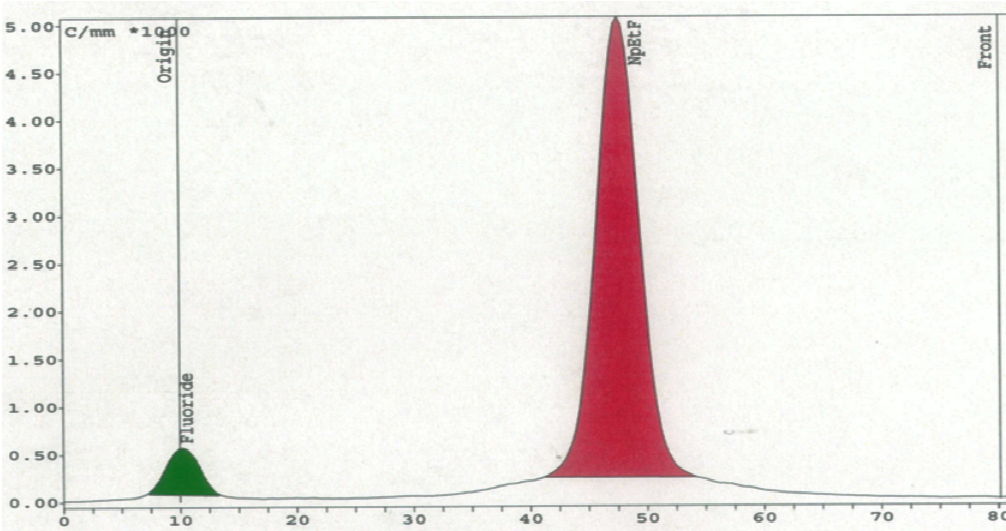
Figure 5. On-column radiofluorination of Np(CH